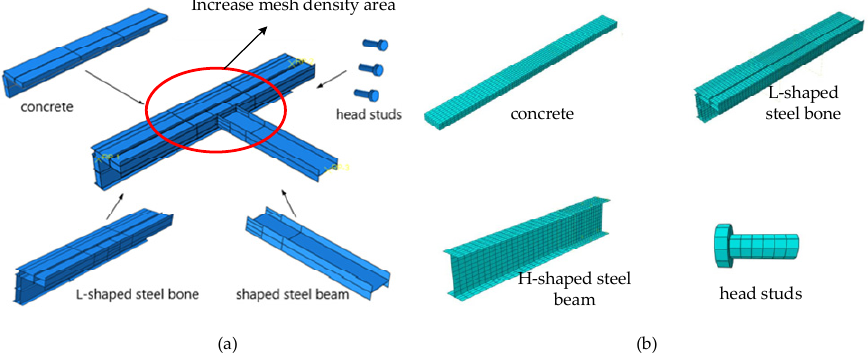
Figure 5. Assembly and mesh schematic diagram. ( a ) Assembly; ( b )